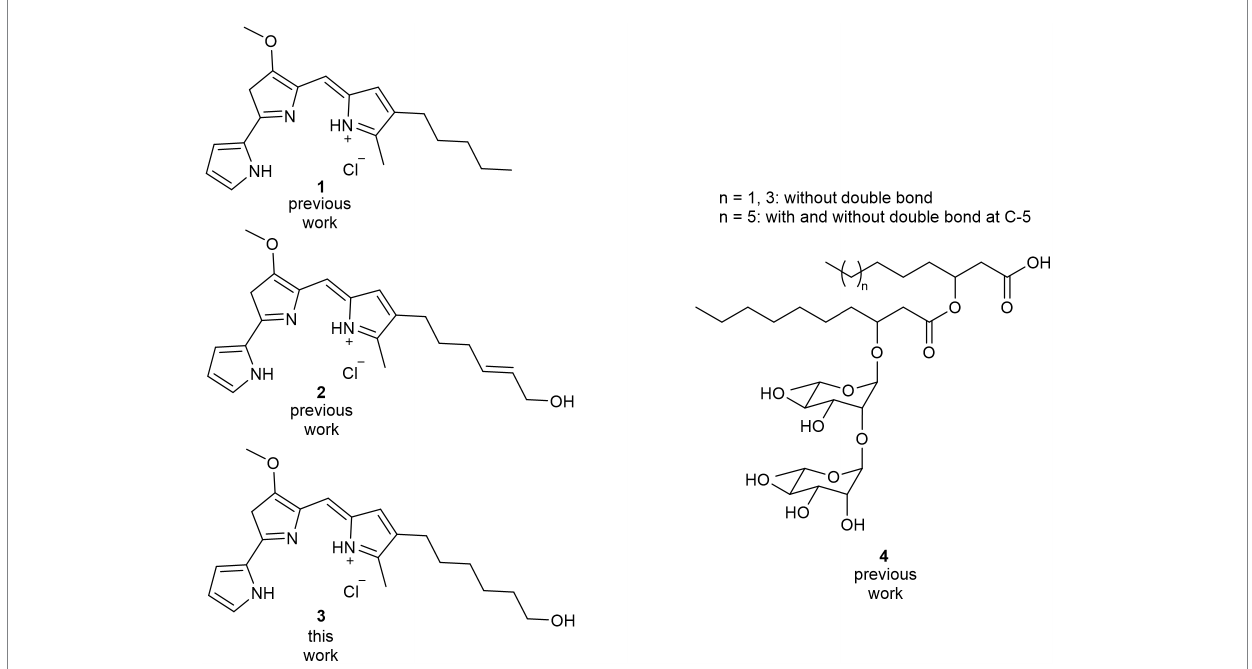
FIGURE 1 Bioactive compounds assessed in this study. The synthesis of prodigiosin (1) and hydroxylated derivative (2) has been established in previous studies. A synthesis route to hydroxylated prodiginine (3) is presented in this study, enabling the compound’s application together with di-rhamnolipids (4) , which can be obtained via microbial biosynthesis as a mixture of congeners as